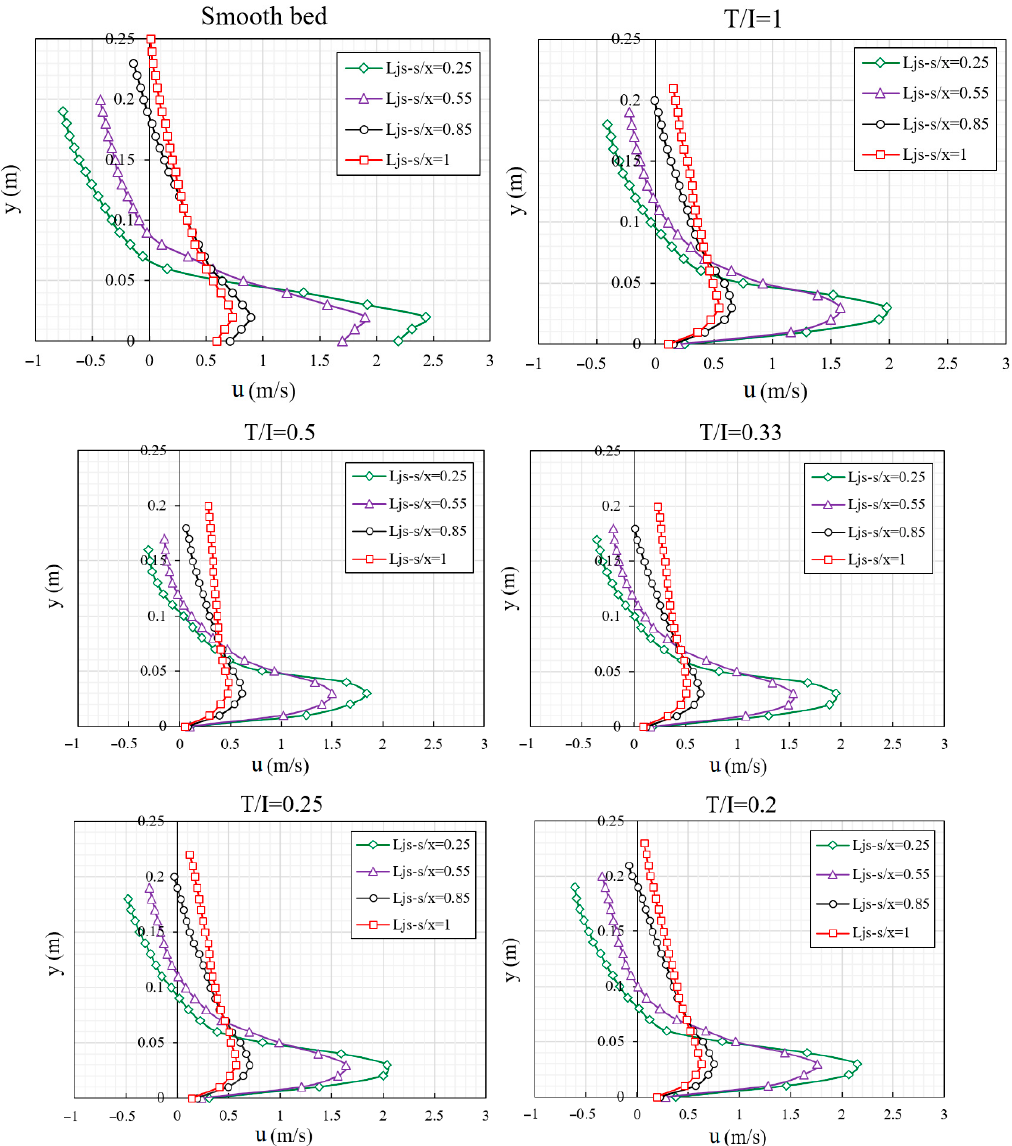
Figure 12. Horizontal velocity distribution at different distances from the sluice gate for the different T/I for Fr 1 = 6.1.